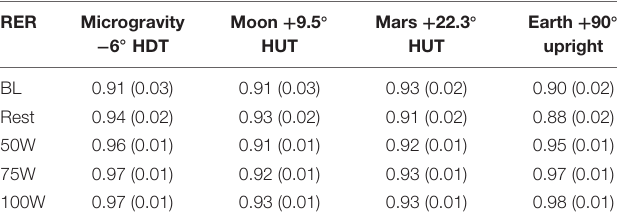
TABLE 1 | Respiratory exchange ratio ( RER=VCO 2 /VO 2 ) averages [mean (SE), including all 14 subjects] during baseline (BL, seated position), at Rest on the platform, and at each work rate of the exercise protocol (50W, 75W, 100W) at the different simulated altered-gravity positions (Microgravity − 6 ◦ HDT, Moon + 9.5 ◦ HUT, Mars + 22.3 ◦ HUT, Earth + 90 ◦